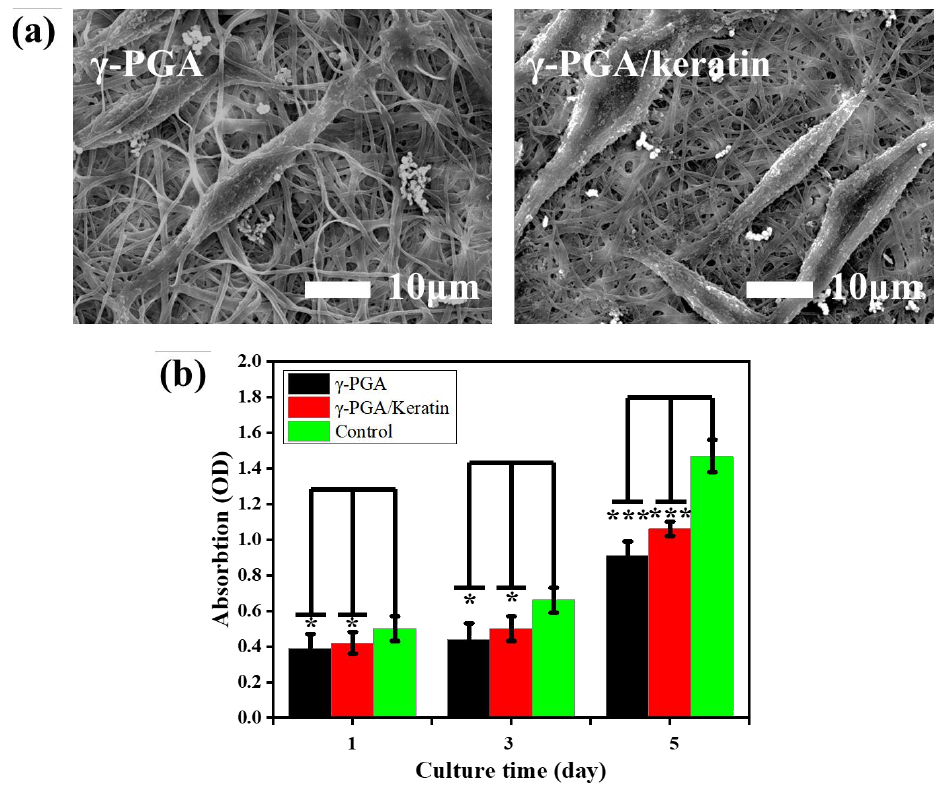
Figure 7. ( a ) SEM images of cells on γ -PGA and γ -PGA/keratin membranes after 3 days of culture. ( b ) Cell viability results of L929 fibroblasts on γ -PGA and γ -PGA/keratin membranes (mean ± SDs; significant difference: * p < 0.05, *** p < 0.01).